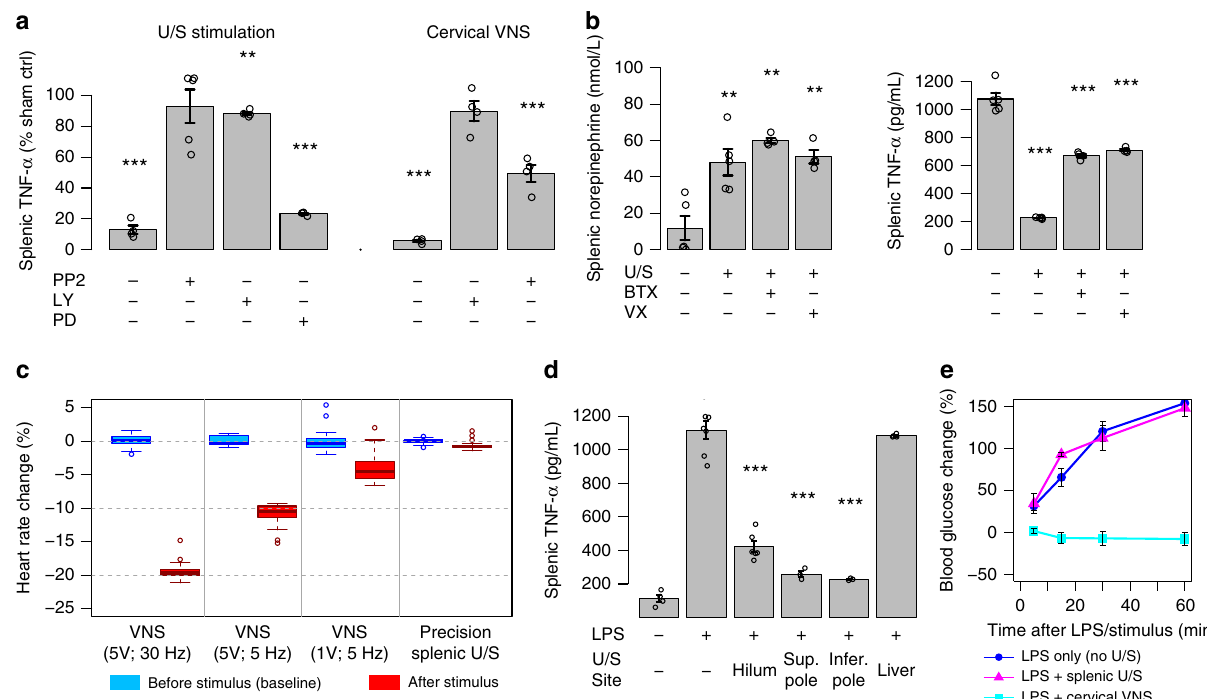
Fig. 5 Comparison of splenic U/S stimulation versus traditional cervical VNS of CAP. a Relative concentrations of splenic TNF are shown for US-stimulated (left; stimulation at 0.83 MPa) versus implant-based VNS (see Methods for details) treated animals (concentrations are shown as a percent change relative to LPS-treated sham stimulation controls). The fi rst bar on the left of each graph shows the effect of ultrasound versus VNS on attenuation of LPS- induced in fl ammation without the addition of any blockers or inhibitors. The remaining bars show the effect of pre-injection of the inhibitors PP2 (4-amino- 5-(4-chlorophenyl)-7-(dimethylethyl)pyrazolo[3,4-d]pyrimidine, partially selective for Src kinase), LY294002 (PI3-kinase selective), and PD98059 (MEK1- and MEK2-selective MAPK inhibitor). n = 4 for each experimental condition. b Data showing the effect of α -bungarotoxin (BTX) or surgical (cervical) vagotomy on splenic concentrations of (left) norepinephrine (NE) and (right) TNF after US stimulation. n = 4 for each experimental condition. c Data comparing the effect of VNS (at several intensities and frequencies) versus splenic US stimulation (at 0.83 MPa) on heart rate (see Methods). d Data showing speci fi city in the modulated TNF response for splenic versus liver U/S stimulation, but similar TNF response shown at different splenic stimulation locations (i.e., splenic hilum, superior and inferior pole). n = 3 for each experimental condition. e Data con fi rming the VNS side-effect on attenuation of LPS-induced hyperglycemia and absence of this side-effect when using splenic U/S stimulation. Relative blood glucose concentrations are shown compared to pre-injection concentration at times of 5, 15, 30, and 60 min for the unstimulated controls (blue-circles), splenic U/S stimulation (purple-triangles), or cervical VNS (light blue-squares). n = 12 for each experimental condition. All experiments in this fi gure were performed using the same U/S parameters as Figs. 3 and